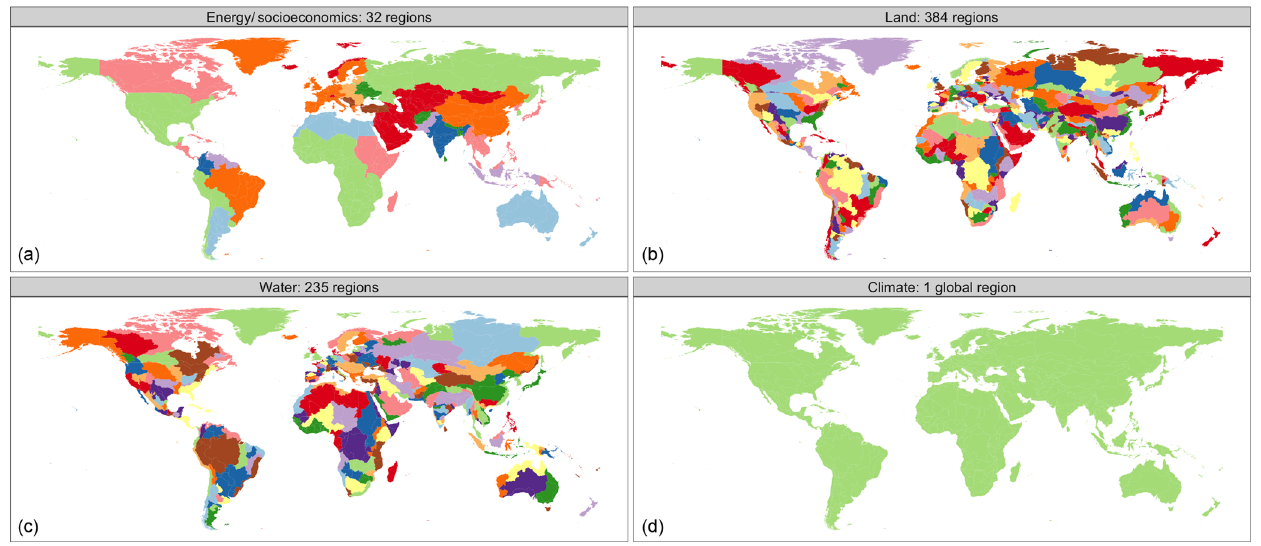
Figure 2. GCAM regional mapping for energy and economy (a) , land (b) , water (c) , and climate (d) . Regions are based on geopolitical boundaries for energy and economy, on water basins for water, and on a combination of geopolitical boundaries and water basins for land.